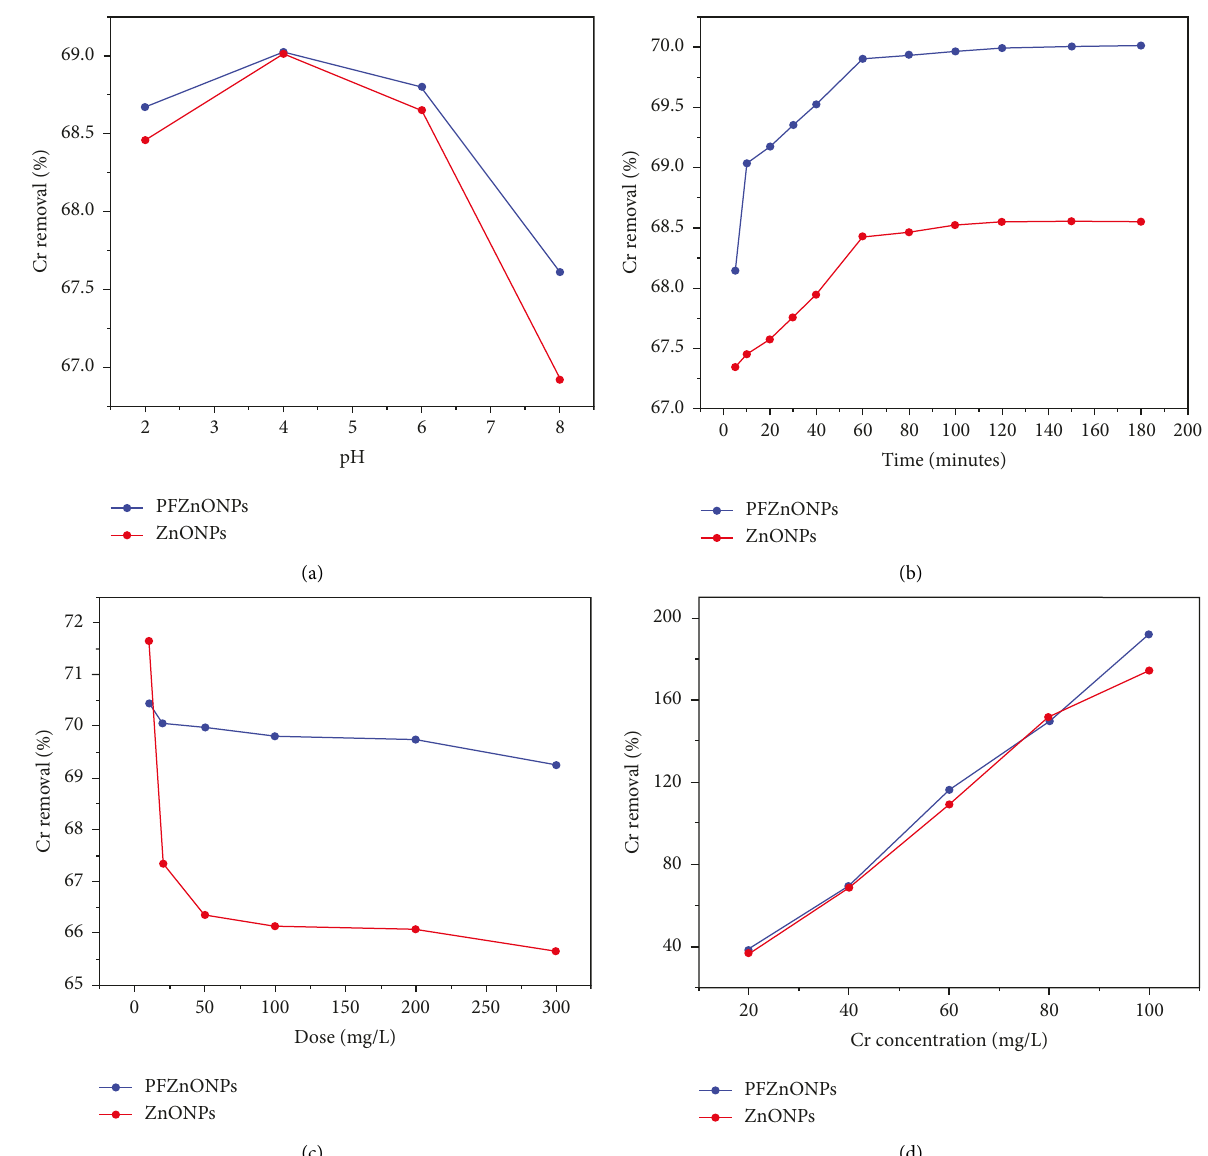
Figure 8: The effect of pH on the adsorption capacity of Cr (VI) (100mg L − 1 ) at 25 ° C and 60min contacting time with 100 mg L − 1 PF- ZnONP. (b) PF-ZnONP at 25 ° C and 100mg L − 1 Cr (VI) at pH 4: effect of contact time on adsorption capacity. (c) Reduction of Cr (VI) (100mg L − 1 ) by PF-ZnONP at pH 4.0 and ambient temperature 25 ° C with a contact time of 60 minutes. (d) Percentage of Cr (VI) removed at different pH 4 concentrations using 100mg L-1 of PF-ZnONP at 25 ° C for 60 minutes. Averages ( n � 3) with coefficients of variation below